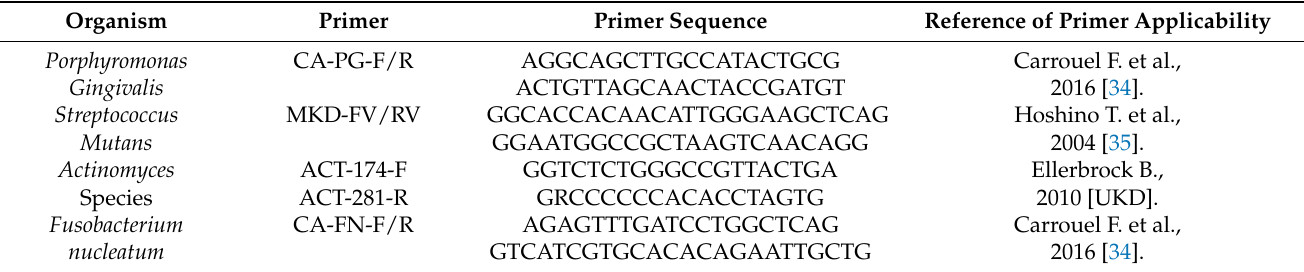
Table 4. Specific primer sequences for qrt-PCR and references of their